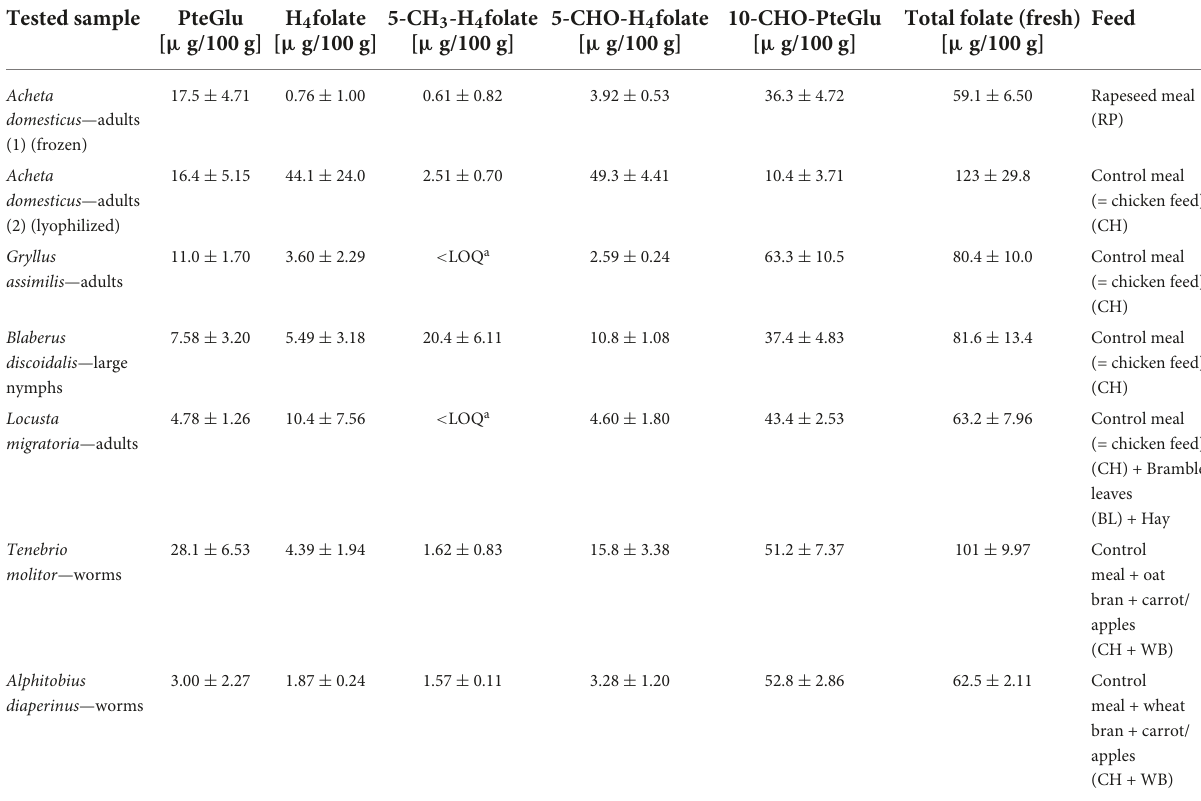
TABLE 1 Total folate content and vitamer distribution in insect samples, calculated as PteGlu [ µ g/100 g of fresh weight]. Tested